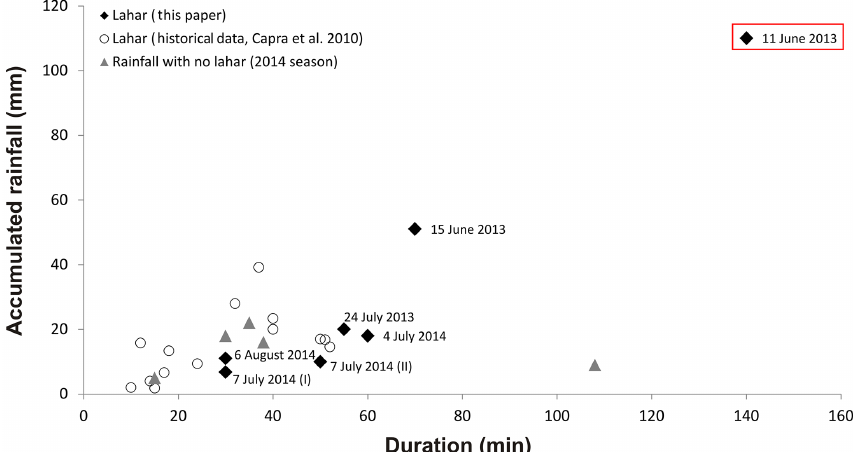
Figure 7. Comparative plot of accumulated rainfall vs. duration of historic and recent events that triggered lahars at Volcán de Colima. The black diamonds represent the data from this paper (2013–2015), and the extraordinary event of 11 June 2013 is denoted by a red box. The historical data (Capra et al., 2010) are represented with empty circles and refer to 2007–2009 years. The gray triangles represent a number of rainfall events that occurred during the 2014 season and that did not trigger a lahar.